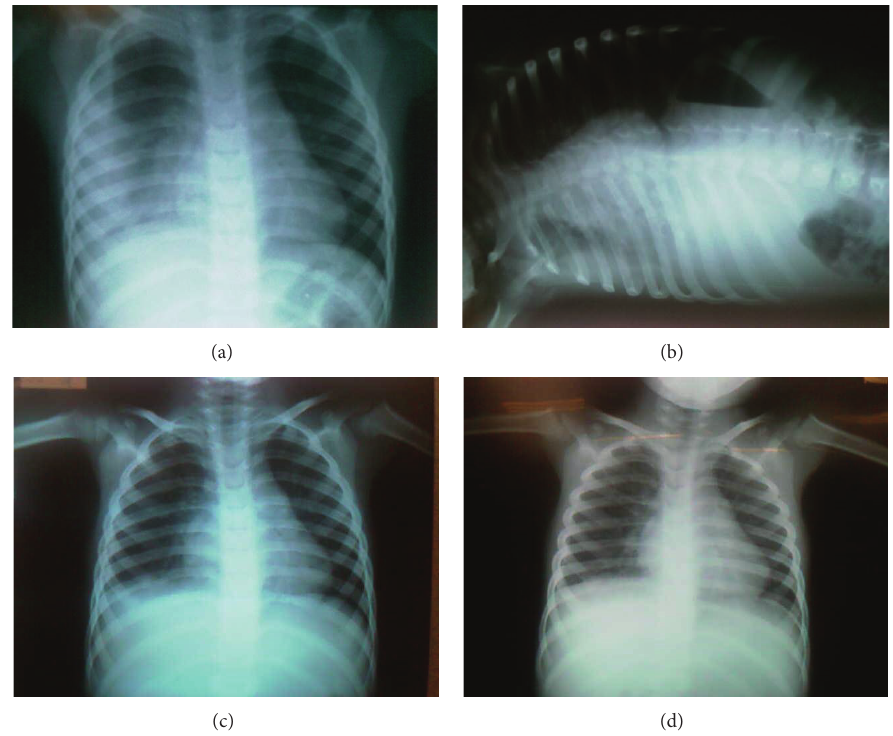
Figure 1: (a) Chest radiograph on the anteroposterior incidence, on day 1 of hospitalization and 15th day of clinical symptoms of pneumonia, showing the lobar pneumonia and a beginning of atelectasis in the right hemithorax. (b) Chest radiography on the incidence of Laurell on 1st day of admission showing pleural effusion in the right hemithorax. (c) Chest radiography on the posterior-anterior incidence on the 4th day of hospitalization, showing atelectasis improvement. (d) Chest radiography on the posterior-anterior incidence on the last day of hospitalization showing atelectasis